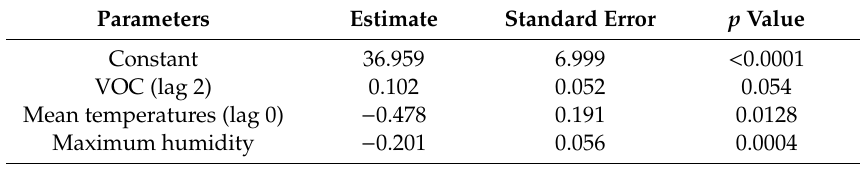
Table 1. Parameters estimates of final multivariate model of emergency visits for VOC.